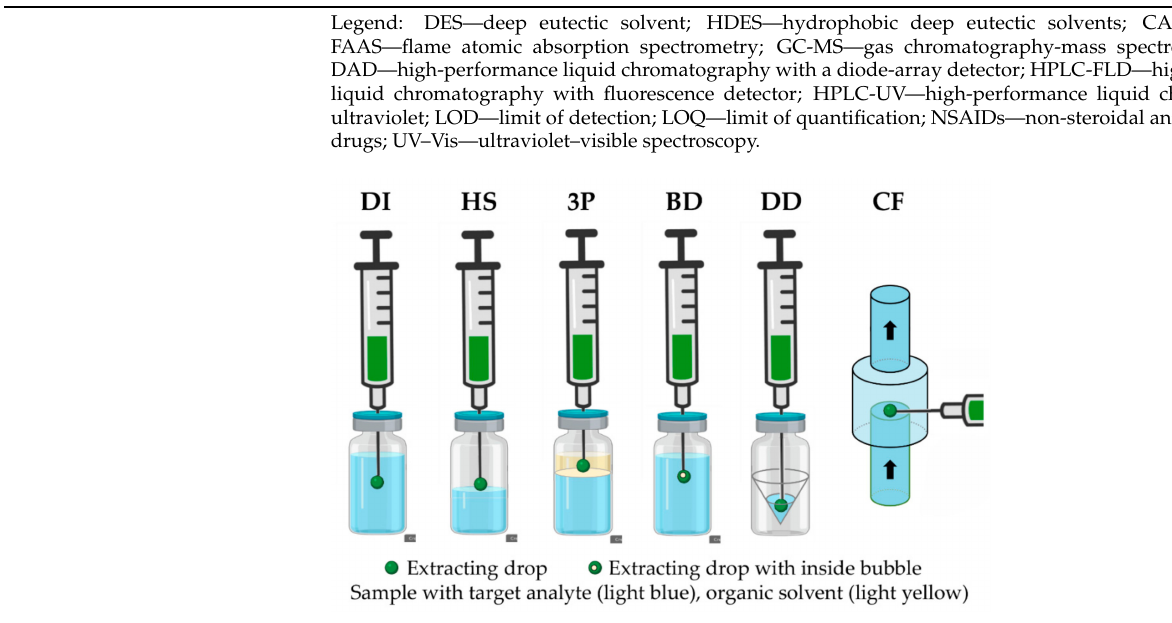
Figure 3. Different modes of SDME: DI—direct immersion SDME, HS—headspace SDME, 3 P—three- phase SDME, BD—bubble-in-drop SDME, DD—drop-to-drop microextraction, CF—continuous-flow microextraction (adapted from Tang et al.